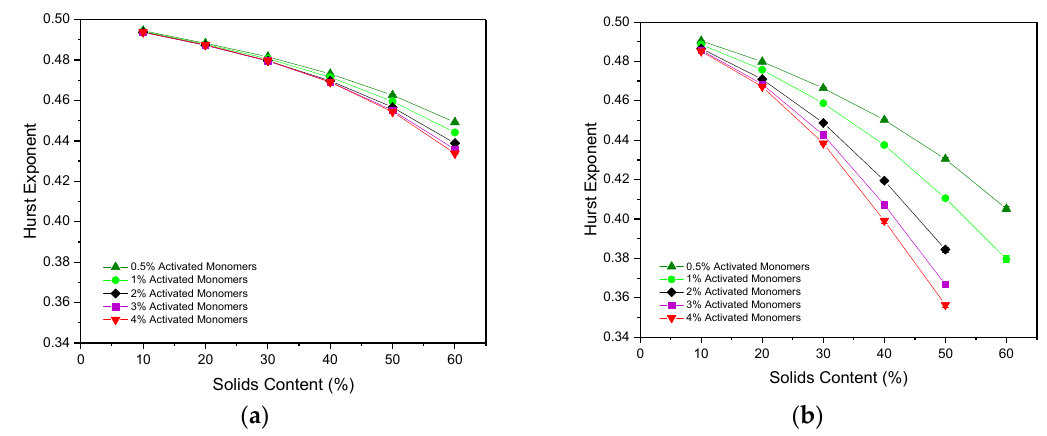
Figure 7. Hurst exponent values calculated for varying solids content ( S c ) and activated monomer ( C c ) values with respect to a diffusing particle of ( a ) Size 1 and ( b ) Size 3. Standard deviation error bars are present around each data point, although may not be visible due to their size relative to the data point marker. Note that a sufficiently percolated structure could not be identified for structures above 1% C c at 60% S c for a particle of three sites in size, hence the missing